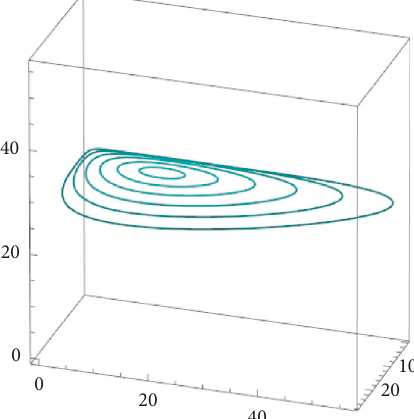
Figure 8: A − B 2 Da − cut .